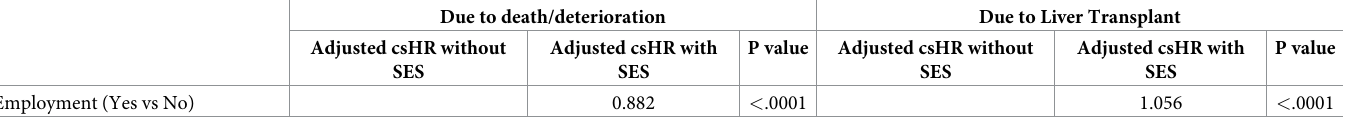
(Table 2). When compared Hispanic with others (all Non-Hispanics combined), Hispanics were less likely to receive liver transplant (Gray’s test P < 0.001) (Fig 1B). (adjusted csHR 0.96, p < 0.001), presence of diabetes (adjusted csHR 0.92, p < 0.001), high serum albumin (adjusted csHR 0.93, p < 0.001),, stage 3/4 encephalopathy (adjusted csHR 1.16, p < 0.001), MELD score (adjusted csHR 1.09, p < 0.001), portal vein thrombosis (adjusted csHR 0.88, p < 0.001), poor performance status (adjusted csHR 1.47, p < 0.001) and causes of liver dis- ease were significantly associated with removal from the list due to liver transplantation (Table